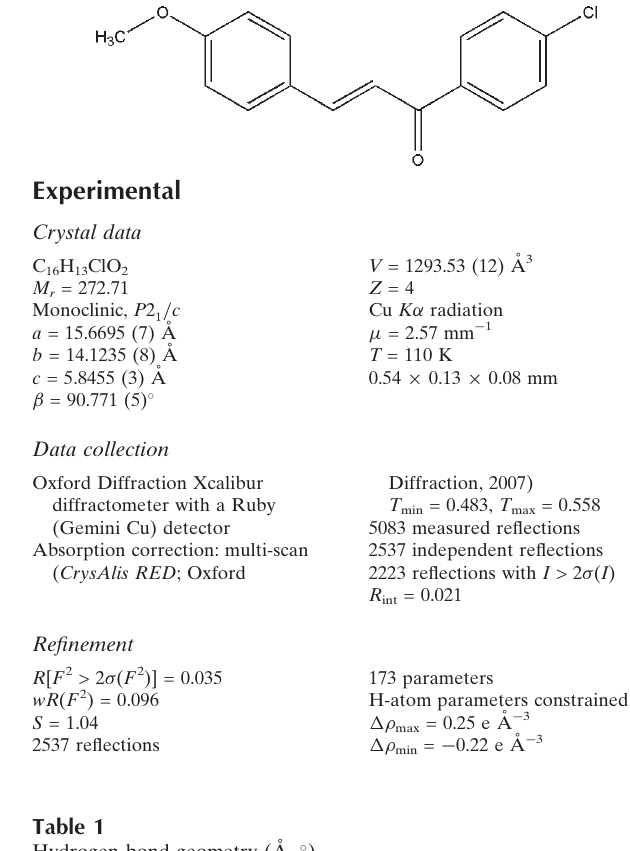
Hydrogen-bond geometry (A˚ , (cid:2) ). Cg 1 and Cg 2 are the centroids of the C1–C6 and C10–C15 rings,